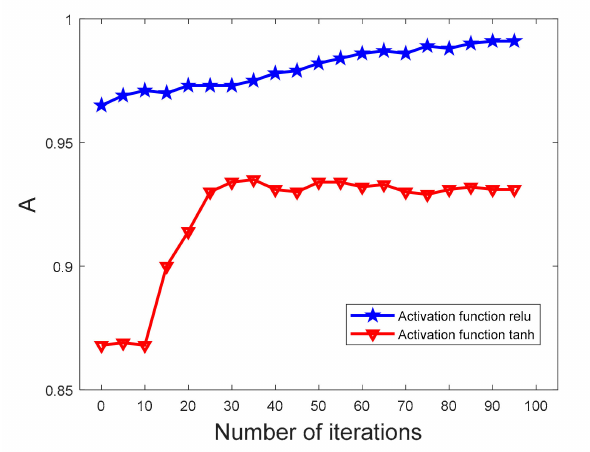
Figure 9. Accuracy curves using the rectified linear unit (ReLU) activation function or Tanh activation